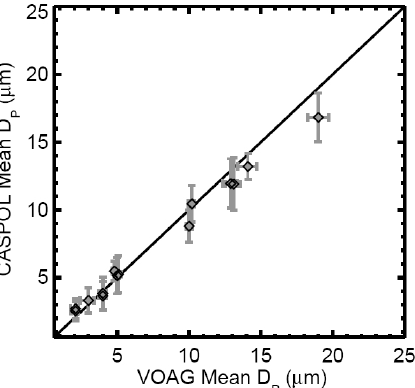
Fig. 4. Size calibration of the CASPOL. The theoretical VOAG mean particle diameter is on the abscissa and the measured CASPOL mean diameter is on the ordinate. The error bars represent measurement uncertainties in both determinations of diameters.